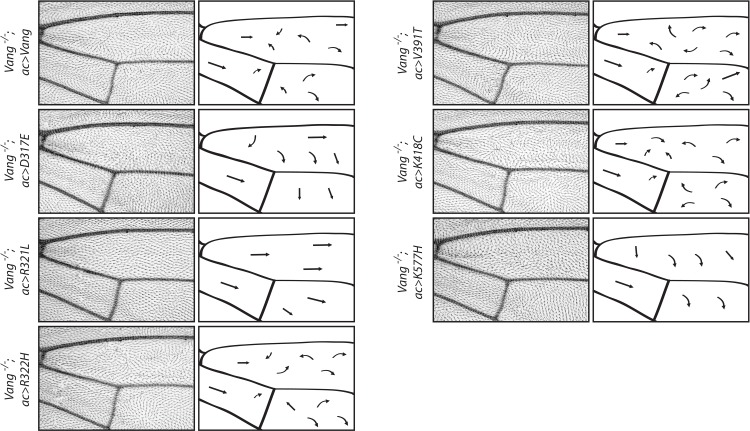
Schematic representation of wings shows flow of hair reorientation in different mutant conditions.Regions 1 and 2 of the adult wing (see Figure 2A) showing hair reorientation phenotypes in the indicated genotype. Arrows show general flow of hair reorientation; note similarity in pattern between WT, R332H, V391T and K418C mutants (swirls, cf. GOF in Figure 2—figure supplement 1), as compared to R321L (wild-type orientation), and D317E and K577H (downwards reorientation, cf. LOF in Figure 2—figure supplement 1).